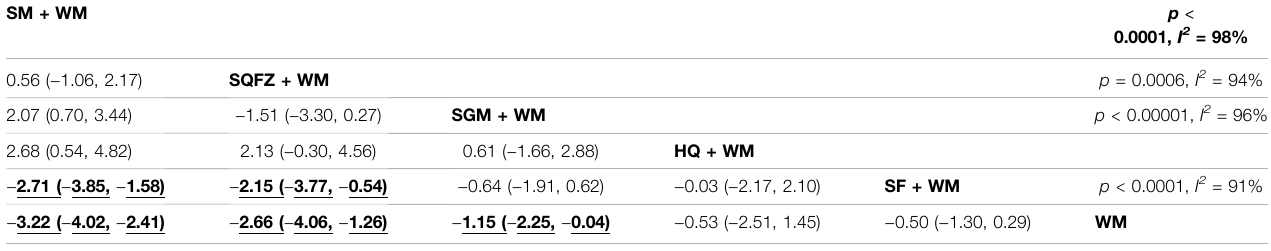
TABLE 5 | SMDs with 95% CIs of CRP. Signi fi cant effects are printed in bold.